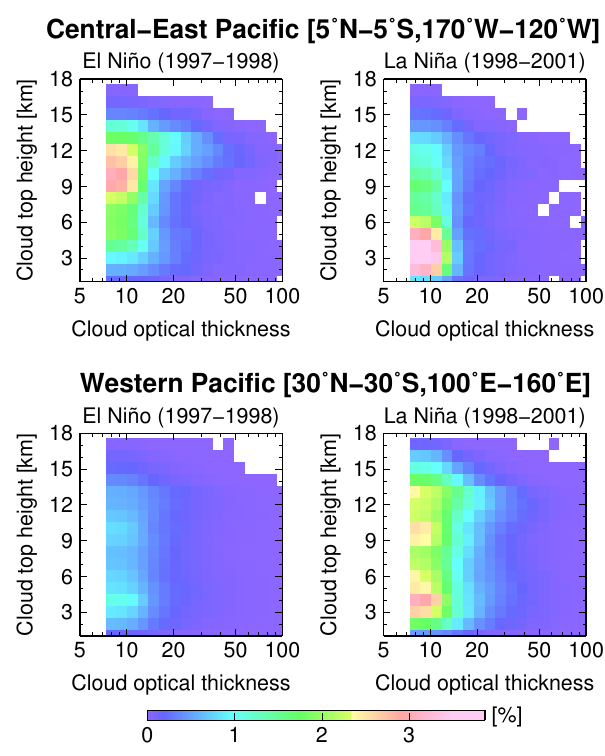
Figure 10. ISCCP-like diagrams of COT vs. CTH for a warm (left “ luca/iup−bremen column) and cold (right column) ENSO phase between April 1997 and June 2011 over the Niño 3.4 index box (top row) and the west- ern tropical warm pool (bottom row).